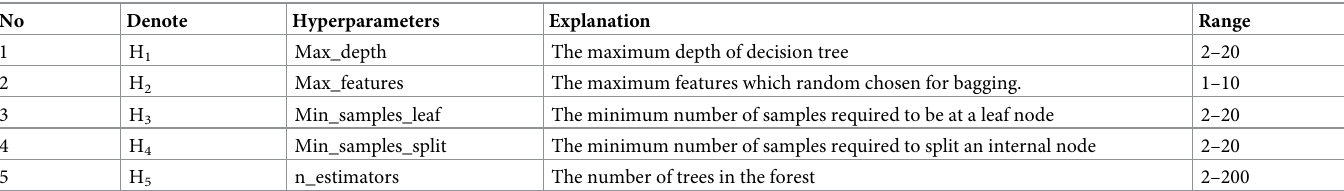
Table 2. Hyper-parameters description and tuning range.